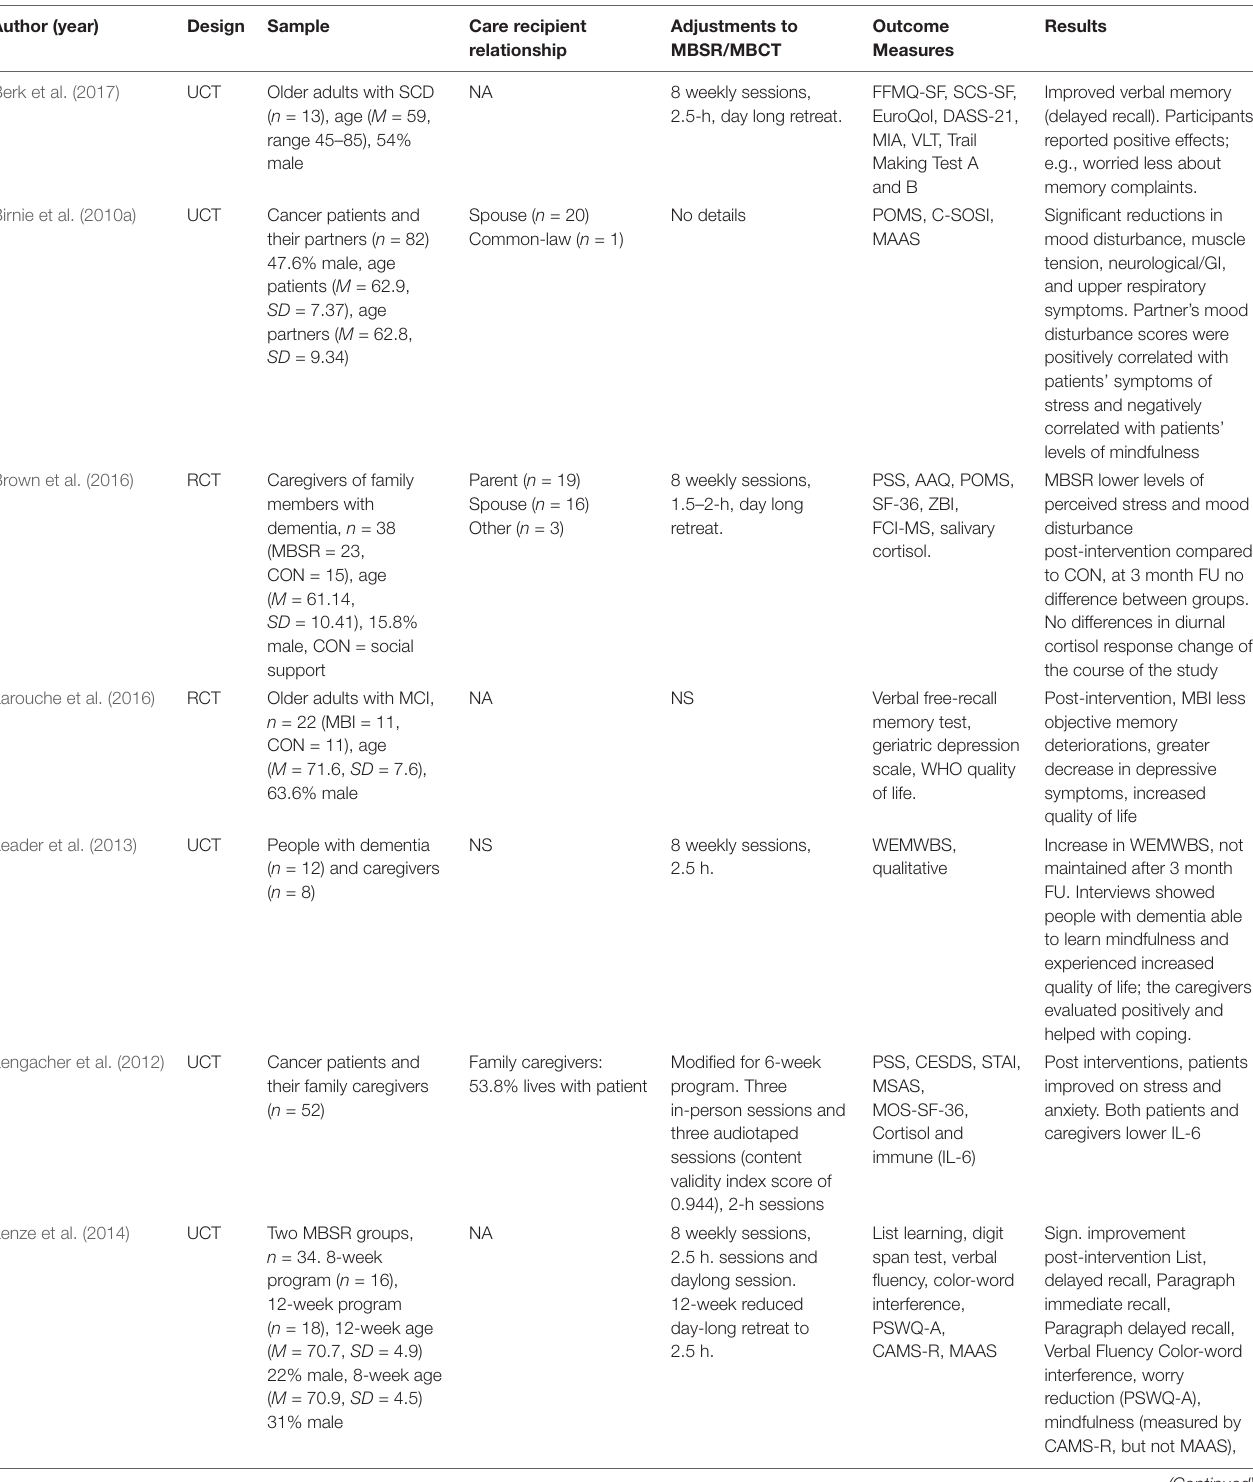
TABLE 1 | Overview of MBI studies with caregiver and patient dyads, and MBI studies with persons with SCD, MCI or dementia. Author